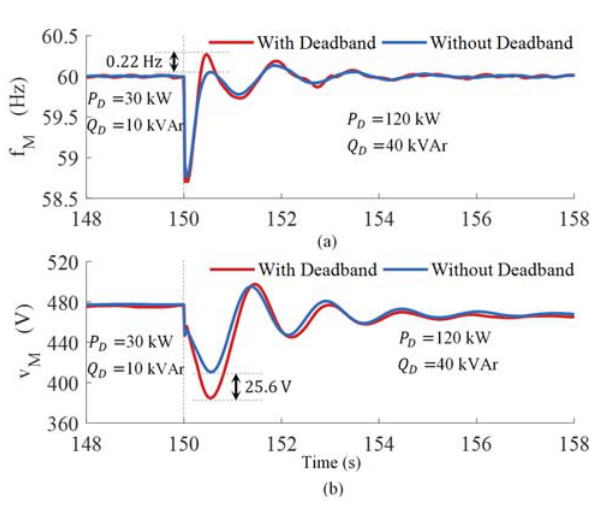
Figure 6. ( a ) Frequency and ( b ) voltage variations of the AC-bus in the presence and absence of dead bands in linear droops when the load demand is stepped up.